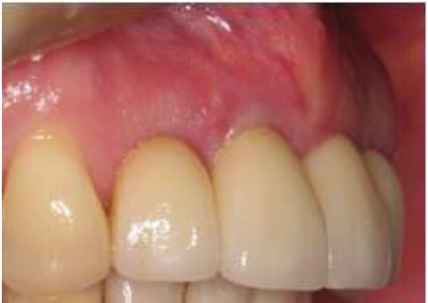
Figure 20: Close-up of tissue graft site and restoration at five-year follow-up.